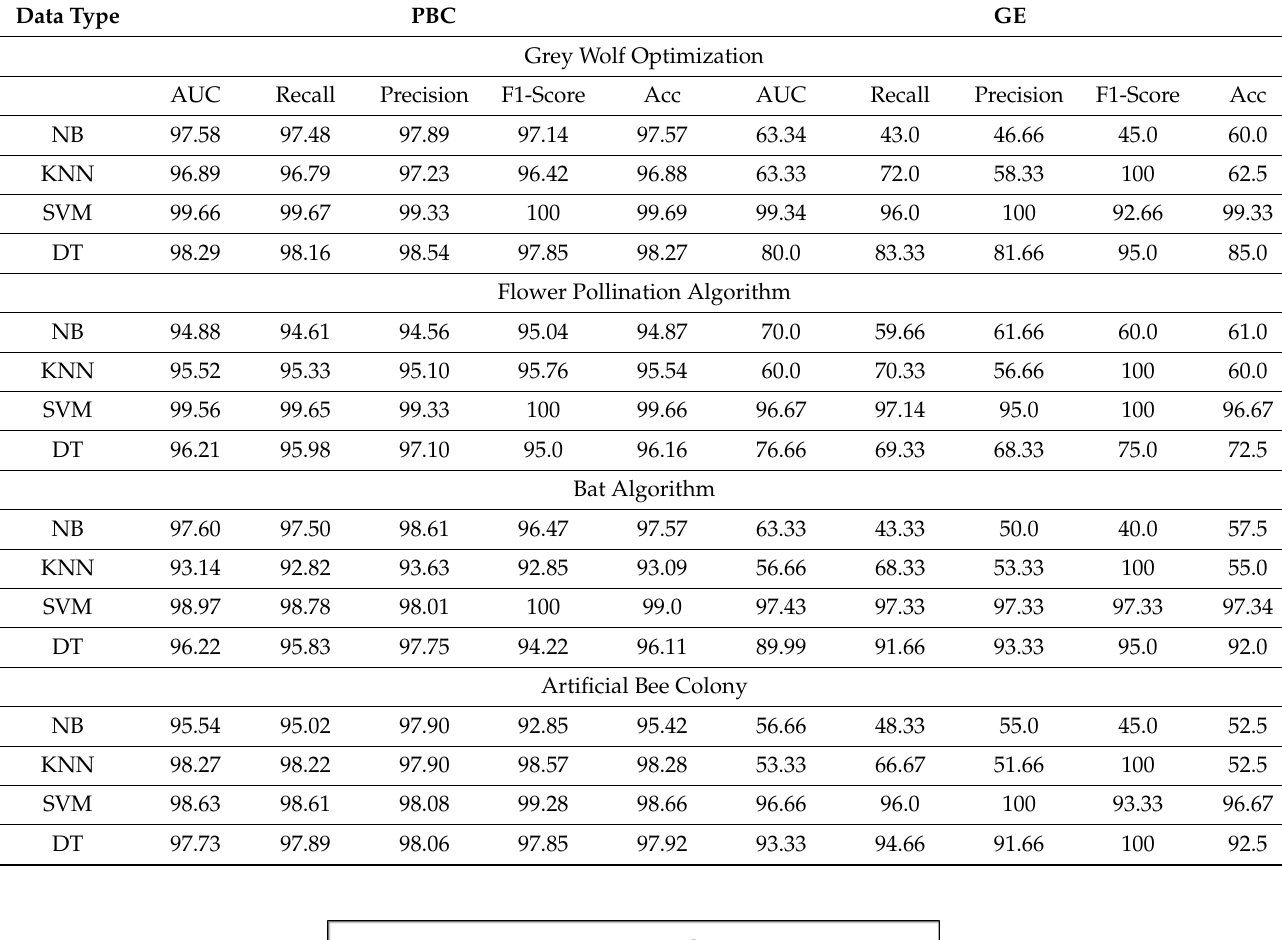
Table 6. Second Experiment Results.